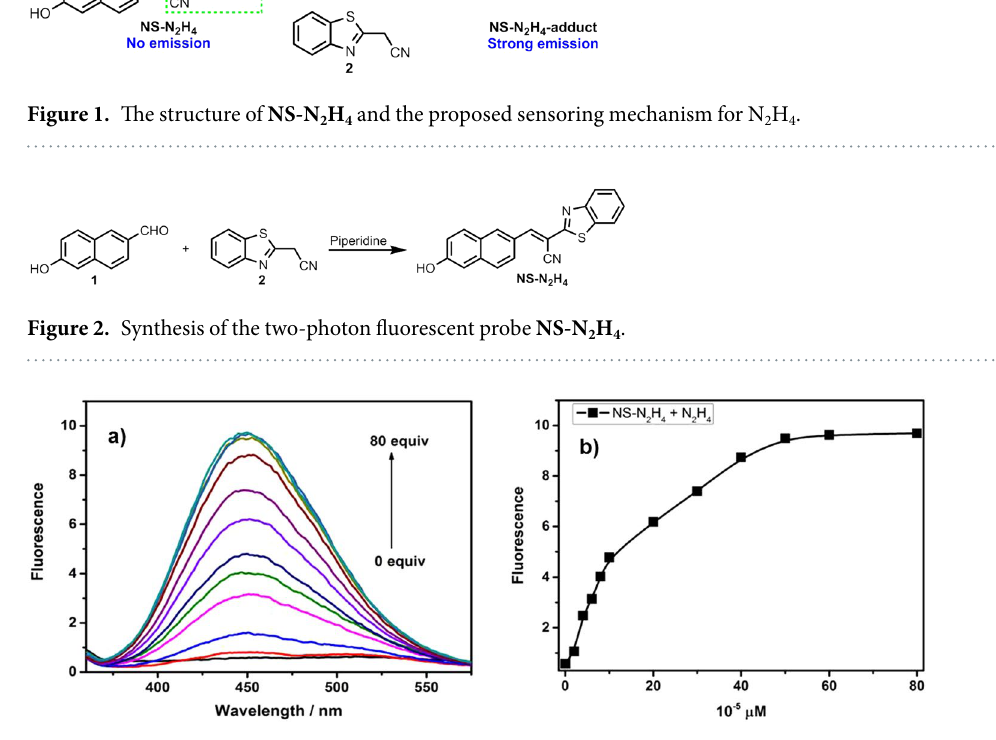
Figure 3. Fluorescence spectra of NS-N 2 H 4 (10 μ M) in pH 7.4 PBS/DMSO (v/v = 2/1) in the absence or presence of N 2 H 4